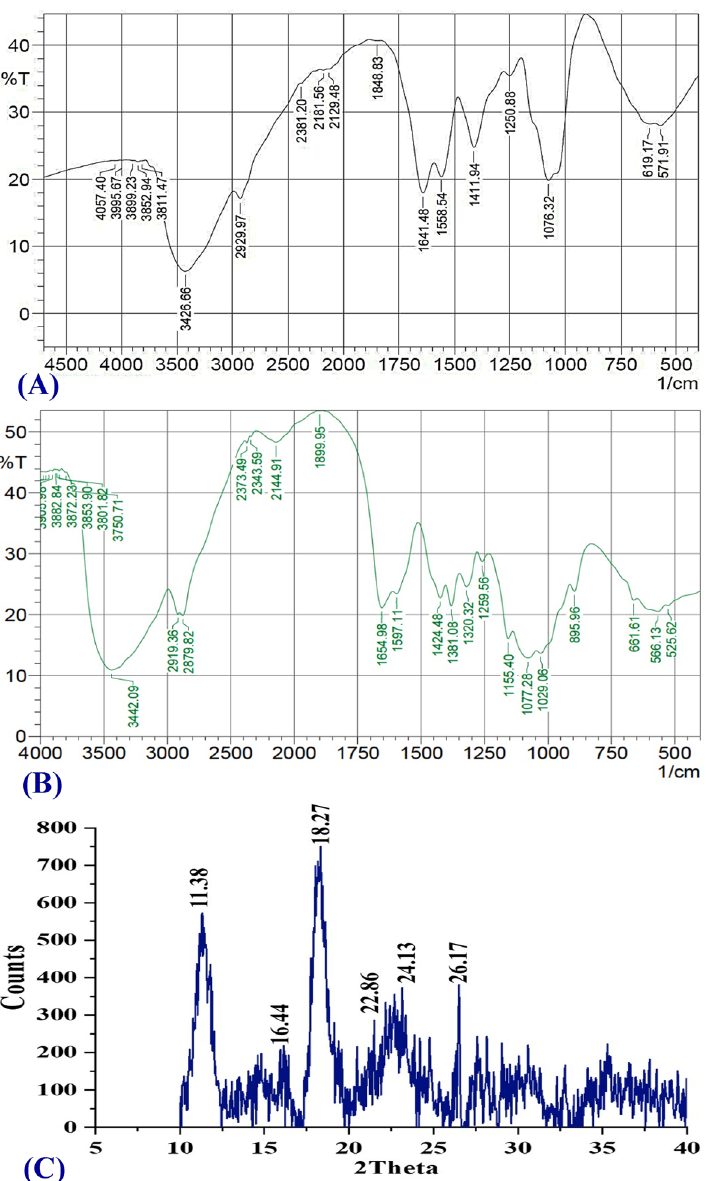
Figure 8. Examination of FTIR for the bio-synthesized chitosan nanoparticles ( A ), for chitosan standard ( B ) and XRD ( C ) of CNPs fabricated using Streptomyces microflavus strain